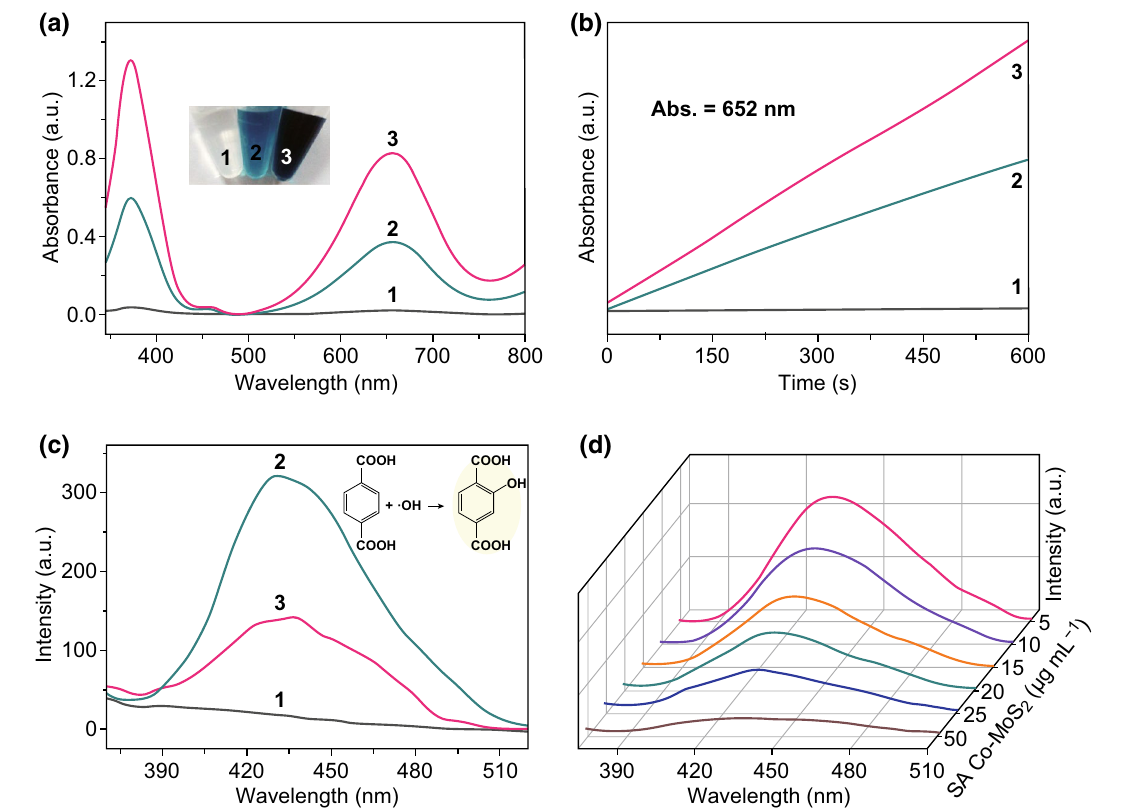
Fig. 2 a UV–Vis spectra of different reaction systems: (1) TMB + H 2 O 2 , (2) TMB + H 2 O 2 + MoS 2 , and (3) TMB + H 2 O 2 + SA Co–MoS 2 . b The time‑dependent absorbance changes at 652 nm and an optical image depicting the color changes. c The formation of ·OH using TA as a fluores‑ cent probe in different reaction systems: (1) TA + H 2 O 2 , (2) TA + H 2 O 2 + MoS 2 , and (3) TA + H 2 O 2 + SA Co–MoS 2 . d Effects of the concentra‑ tion of SA Co–MoS 2 on the changes in ·OH with TA as the fluorescence probe. (Color figure